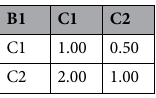
Table 4. Judgment matrix B1-Ci (i = 1–2).